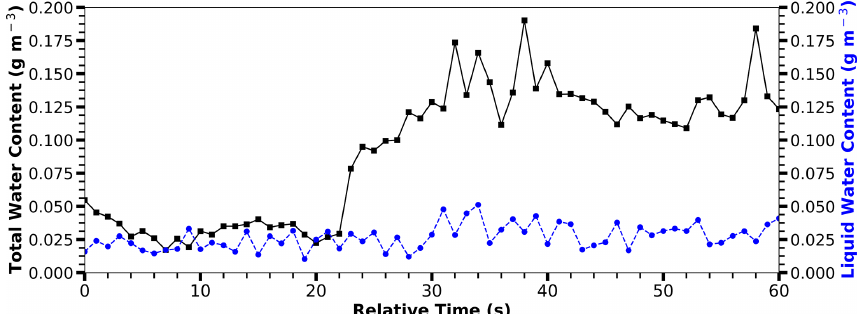
Figure 12. Nevzorov probe-measured total water content (TWC) (solid, square black) and liquid water content (LWC) (dashed, round blue) for the − 33 ◦ C case (Table 2). Each point represents 1s of Nevzorov data. The average LWC is 0 . 022 ± 0 . 009gm − 3 , and the average TWC is 0 . 032 ± 0 . 008gm − 3 during times of Optical Ice Detector (OID) and external cloud probe (ECP) backscatter coefficient agreement (0 to 20s). The average LWC is 0 . 027 ± 0 . 009gm − 3 , and the average TWC is 0 . 092 ± 0 . 05gm − 3 during times of OID and ECP backscatter coefficient disagreement (30 to